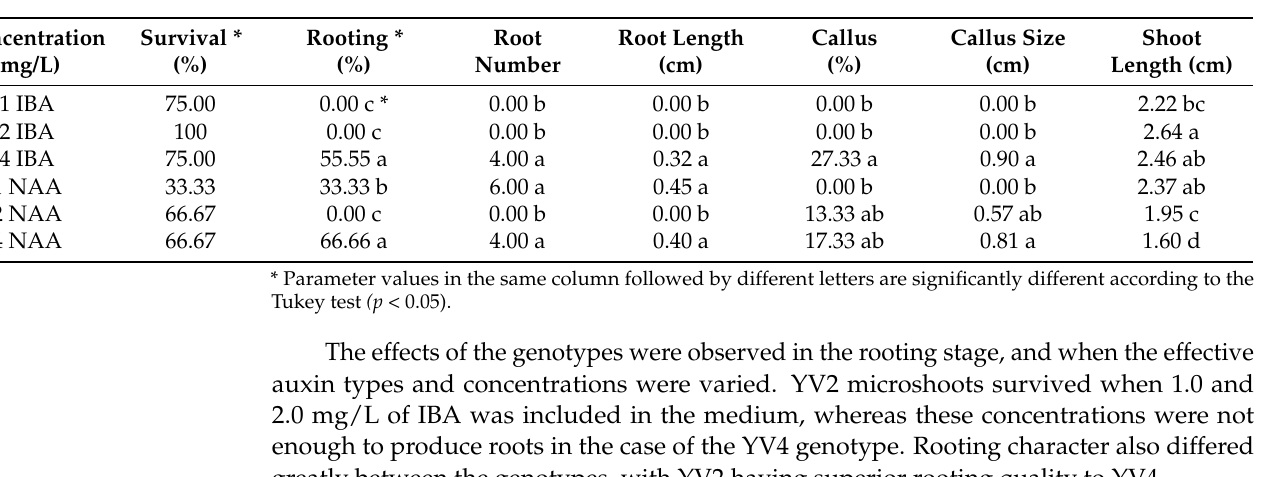
Table 6. The effects of auxins (IBA and NAA) on the rooting of in vitro-cultured microshoots of YV4 on WPM